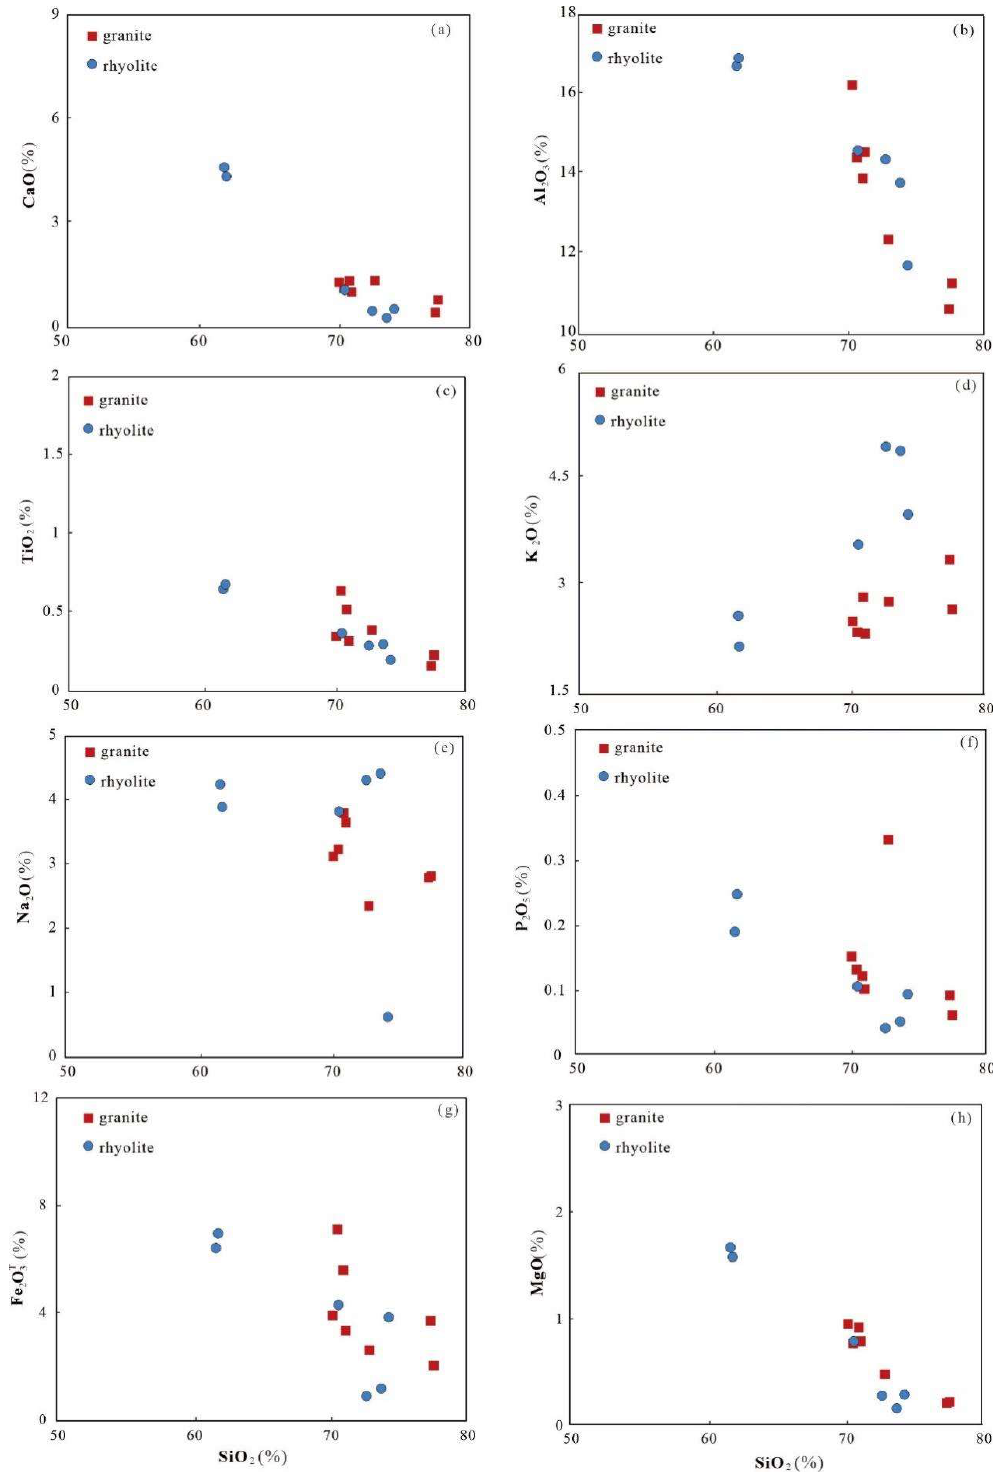
Figure 7. Harker diagram of the Early Cretaceous magmatic rock from the Badaguan area. ( a ): CaO−SiO 2 diagrams; ( b ): Al 2 O 3 −SiO 2 diagrams; ( c ): TiO 2 −SiO 2 diagrams; ( d ): K 2 O−SiO 2 diagrams; ( e ): Na 2 O−SiO 2 diagrams; ( f ): P 2 O 5 −SiO 2 diagrams; ( g ): Fe 2 O 3T −SiO 2 diagrams; ( h ): MgO−SiO 2 diagrams;